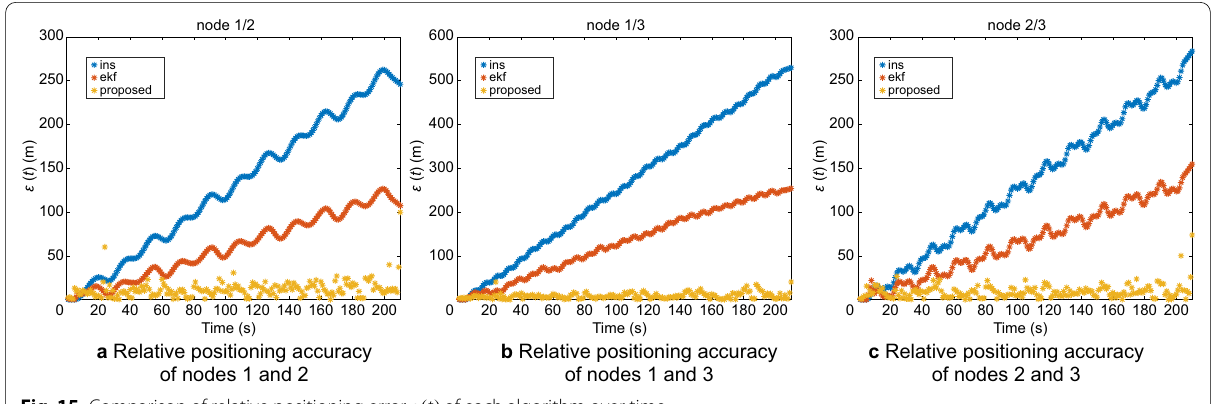
Fig. 15 Comparison of relative positioning error ε( t ) of each algorithm over time